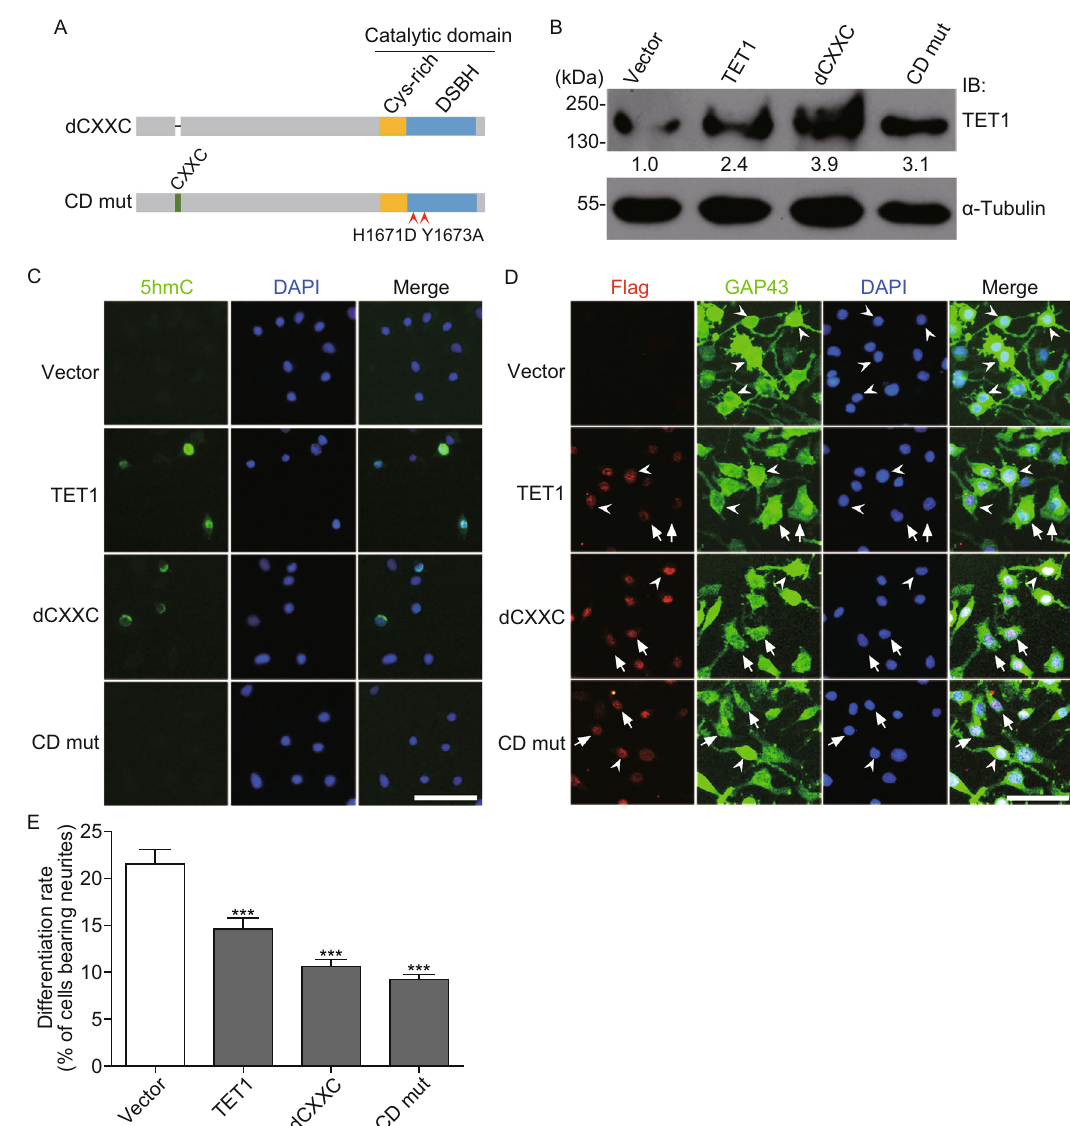
Figure 5. Overexpression of TET1 mutants inhibits neuronal differentiation of Neuro2a cells. (A) Schematic presentation of structure of TET1 mutants. (B) Neuro2a cells transfected with control vector (Vector) or vector harboring WT TET1 (TET1), TET1 dCXXC (dCXXC), and TET1 CD mut (CD mut) were lysed and immunoblotted with TET1 antibody. (C) Immunostaining of 5hmC after overexpression of WT TET1 (TET1), TET1 dCXXC (dCXXC), and TET1 CD mut (CD mut). (D) Neuro2a cells transfected with control vector (Vector) or vector harboring WT TET1 (TET1), TET1 dCXXC (dCXXC), and TET1 CD mut (CD mut) gene were co- immunostained with Flag and GAP43 antibodies. Arrowheads indicate the differentiated cells and arrows indicate undifferentiated cells. Scale bar = 100 μ m. (E) Quanti fi cation of the differentiation rates from Neuro2a cells after overexpression of WT TET1 (TET1), TET1 dCXXC (dCXXC), and TET1 CD mut (CD mut). Values are mean ± SEM, *** P